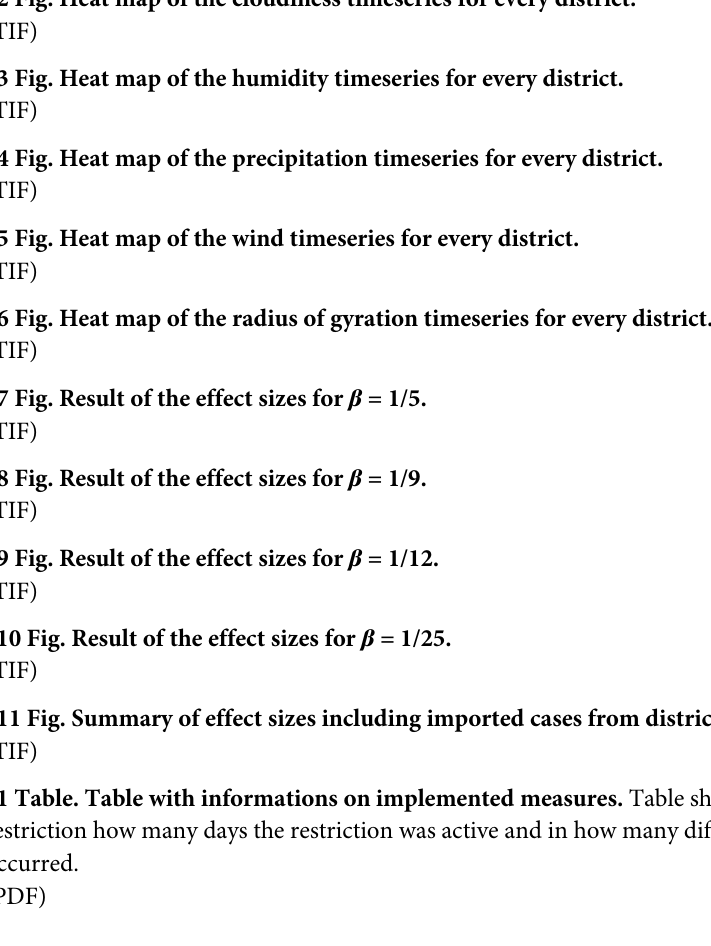
S2 Fig. Heat map of the cloudiness timeseries for every district. S3 Fig. Heat map of the humidity timeseries for every district. S4 Fig. Heat map of the precipitation timeseries for every district. S5 Fig. Heat map of the wind timeseries for every district. S6 Fig. Heat map of the radius of gyration timeseries for every district. S7 Fig. Result of the effect sizes for β = 1/5. S8 Fig. Result of the effect sizes for β = 1/9. S9 Fig. Result of the effect sizes for β = 1/12. S10 Fig. Result of the effect sizes for β = 1/25. S11 Fig. Summary of effect sizes including imported cases from districts. S1 Table. Table with informations on implemented measures. Table showing for each restriction how many days the restriction was active and in how many different districts it